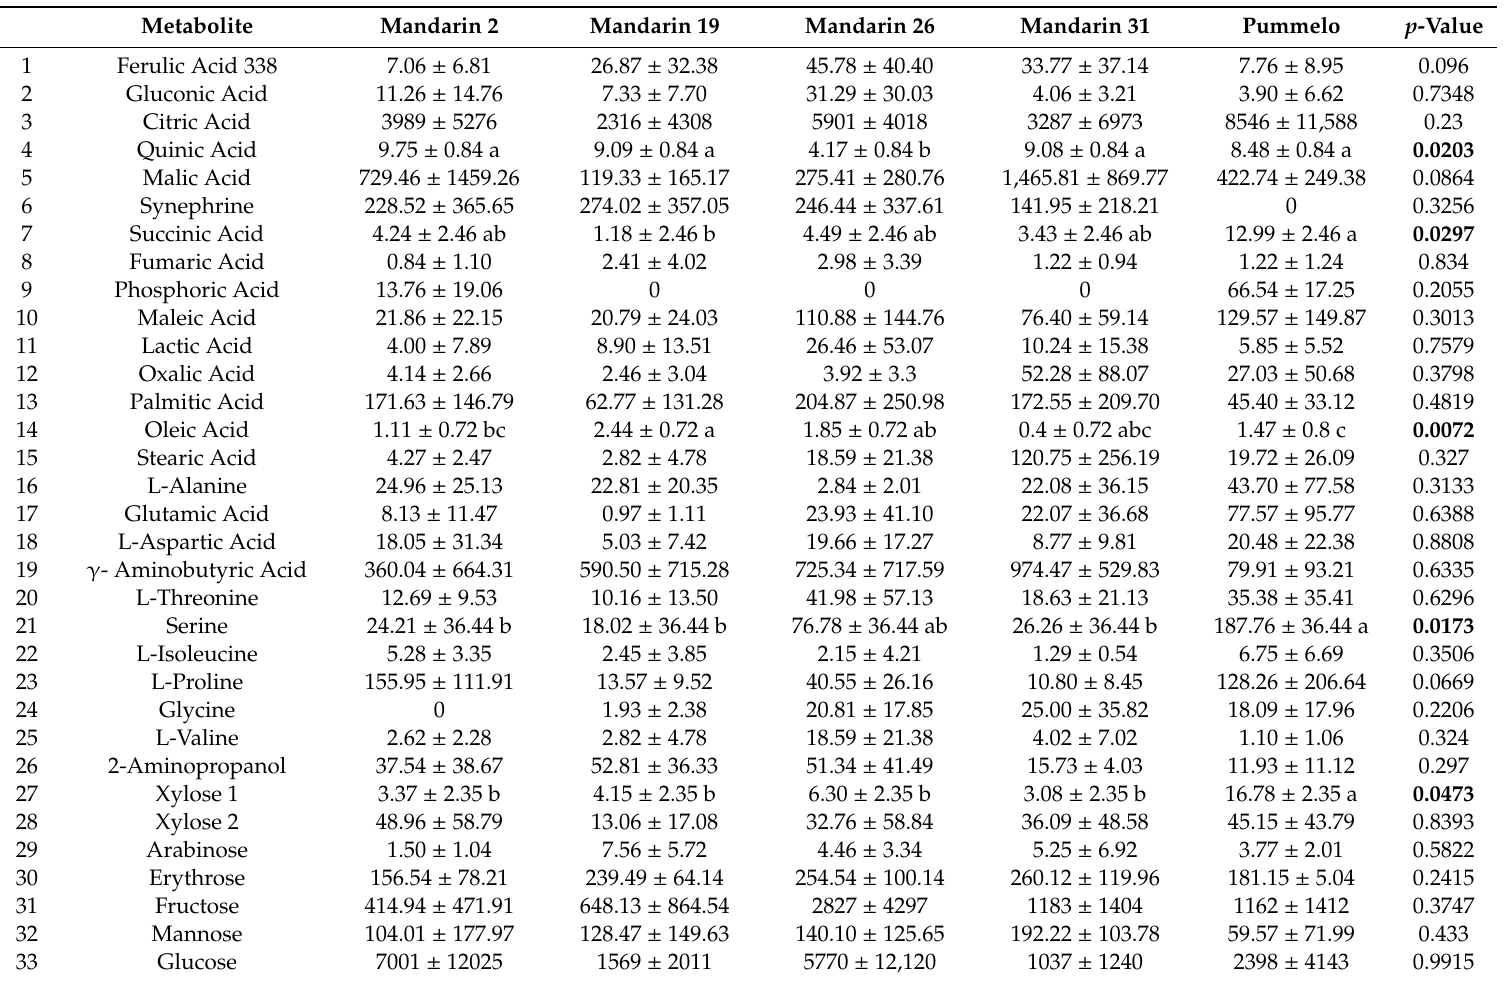
Table 4. Metabolites found in leaf tissue of Cleopatra Mandarin selections and